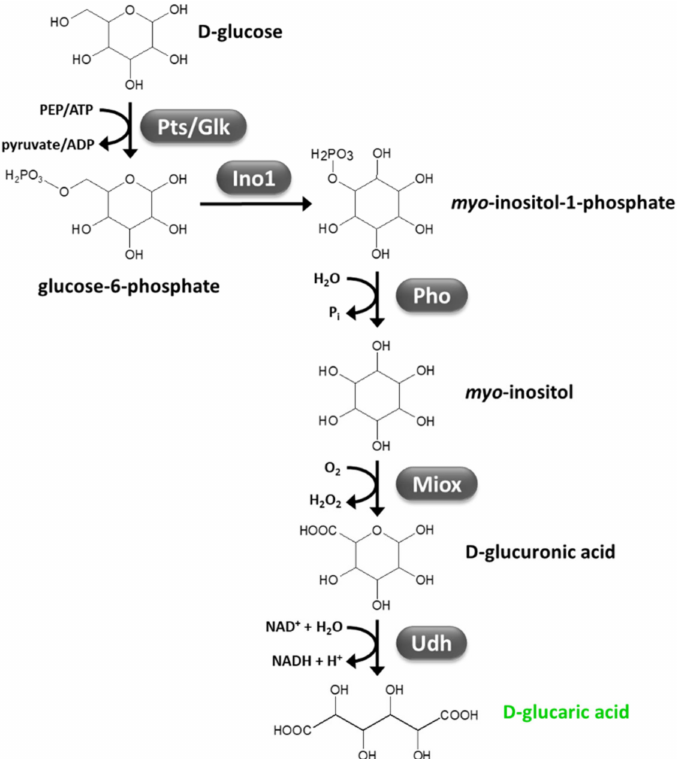
Figure 5. Synthetic pathway for D-glucaric acid production from glucose (adapted from [23,112]). Glk, glucokinase; Ino1, myo -inositol-1-phosphate synthase; Miox, myo -inositol oxygenase; PEP, phosphoenolpyruvate; Pho, phosphatase; Pts, phosphoenolpyruvate-dependent phosphotransferase; Udh, uronate